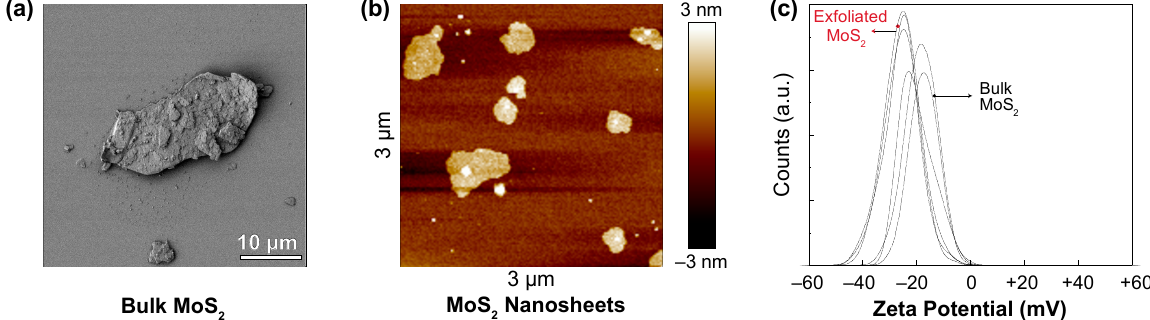
Figure 2. ( a ) Scanning electron microscopy image of bulk MoS 2 , ( b ) atomic force microscopy image of 2D MoS 2 nanosheets, and ( c ) zeta potential of bulk and exfoliated MoS 2 . Table 2. The structural and surface characteristics of bulk and exfoliated MoS 2 used in this